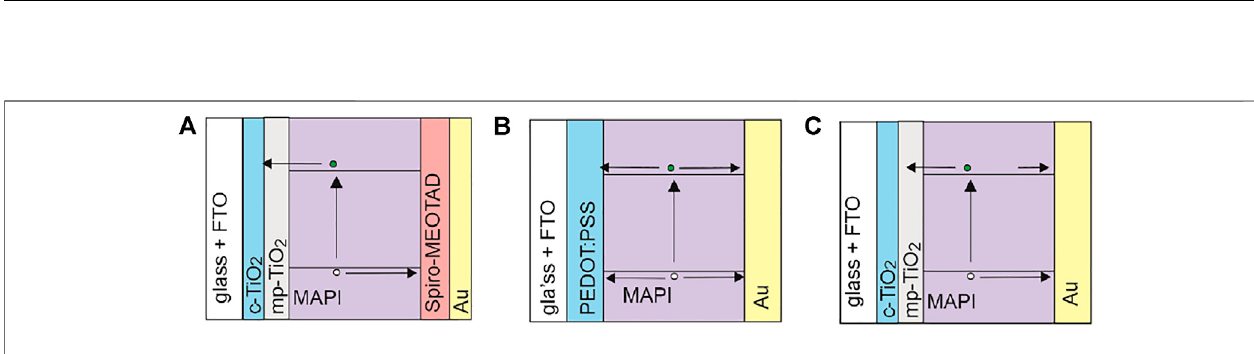
FIGURE 5 | Schematic of photogeneration of an electron-hole pair under illumination for (A) FTO/c-TiO optoelectronic FTO/PEDOT:PSS/MAPI/Au memristor device, (C) optoelectronic FTO/c-TiO 2 /mp-TiO 2 /MAPI/Au memristor device.